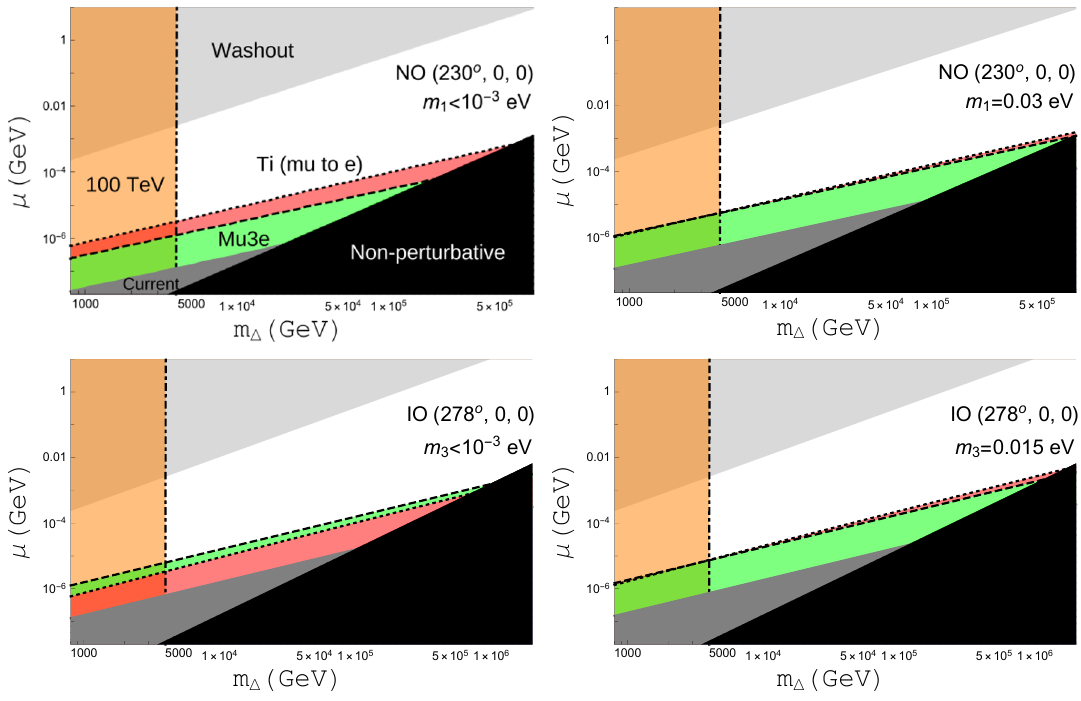
Figure 7 . The reach of LFV searches is depicted for the current best fit parameters, given in table 1, for different m 1 mass regimes and α 21 = α 31 = 0 . The upper bounds on the future sensitivities of the future Mu3e and µ to e conversion experiments are denoted by the dashed line (subtending the green region) and dotted line (subtending the red region) respectively [101]. The discovery potential of a future 100 TeV collider is depicted by the orange region, subtended by the black dot-dashed line [105]. Significant lepton asymmetry washout occurs for parameters within the Light Grey region, and non-perturbative neutrino Yukawa couplings (Black). The grey region denotes the current best limits either from µ → 3 e or µ → eγ constraints, depending on the neutrino parameters [100]. The region subtended by these three constraints is the parameter region where successful Leptogenesis, neutrino mass generation, and inflation can occur. The other neutrino parameters are given by the best fit parameters in table 1. Both the NO (Top) and IO (Bottom) scenarios are